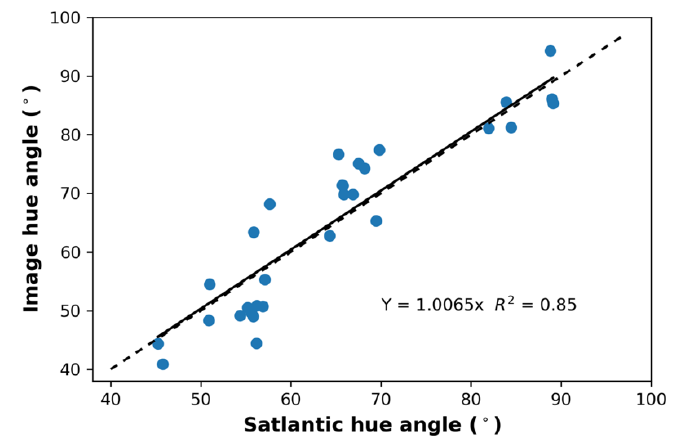
Figure 10. Correlation between hyperspectral (Satlantic) and mean EoW image (WACODI) hue angle. The solid line represents the regression through the data, and the dashed line represents the 1:1 relationship.